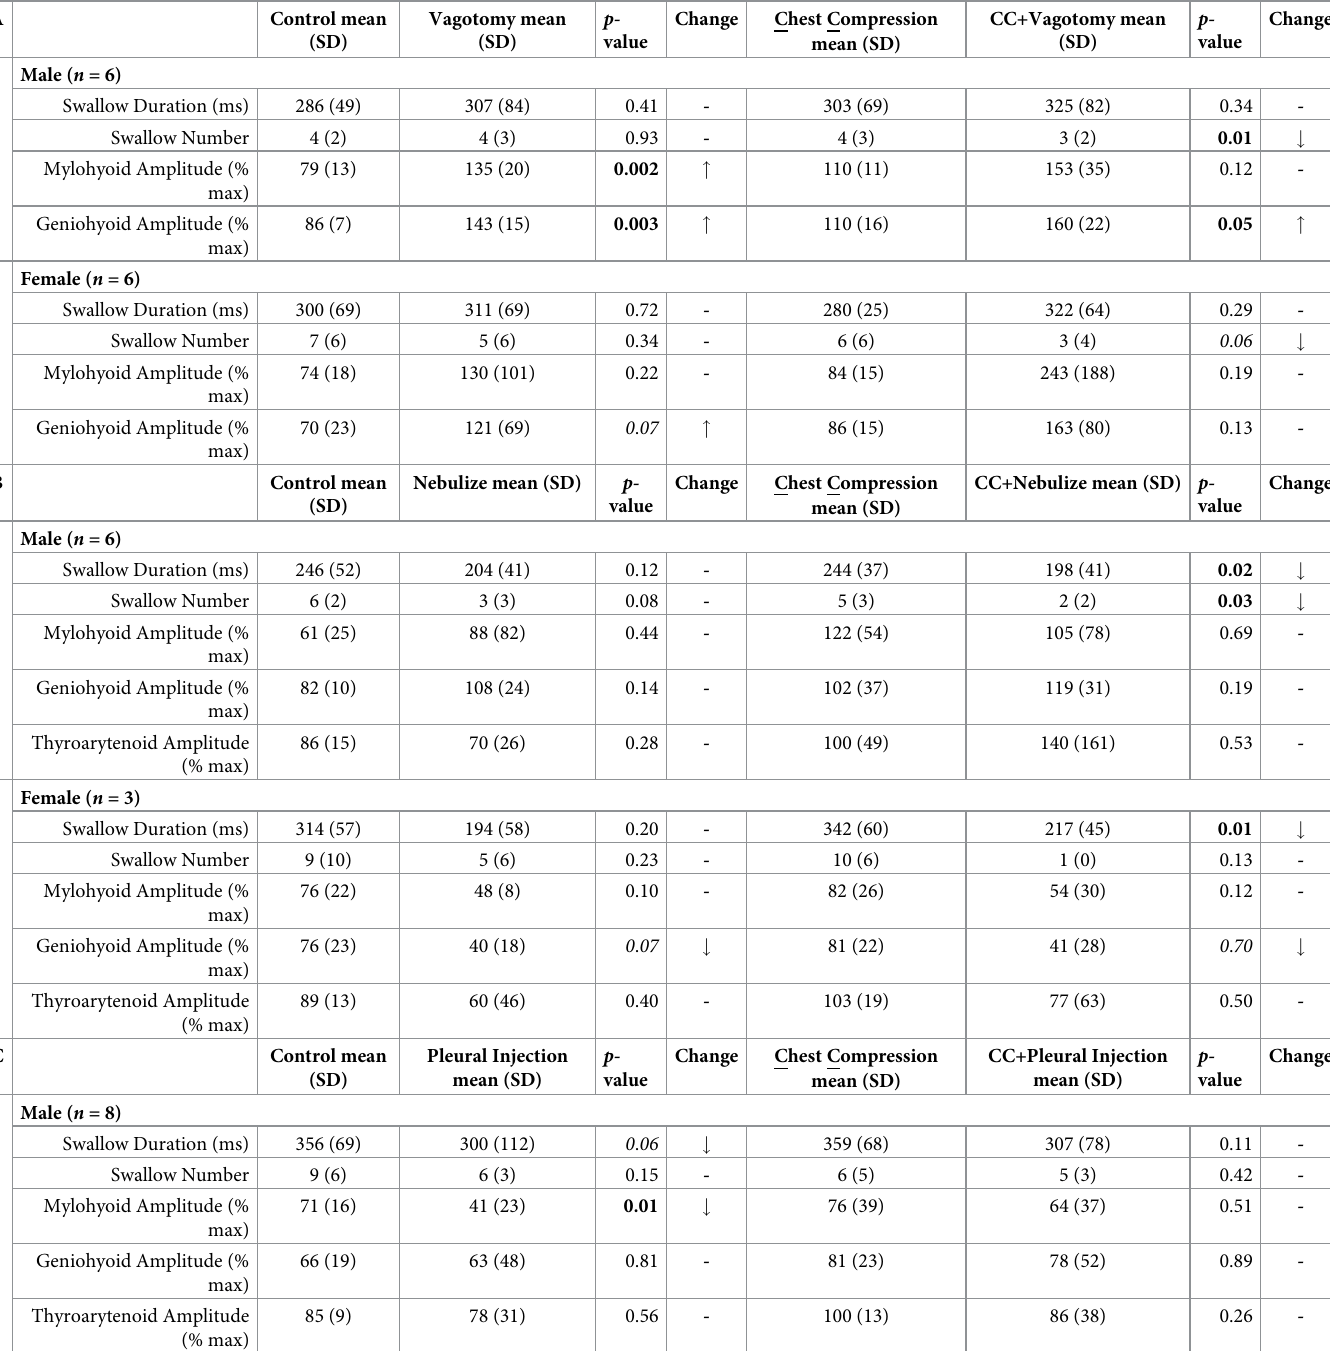
Table 3. Means, Standard Deviation (SD), p -values, and direction of change for swallow parameters during conditions of control (no feedback modulation or chest compression), feedback modulation alone (e.g. vagotomy), chest compression alone (without feedback modulation), and Chest Compression (CC) during feedback modulation conditions for both male and female groups. The left half of the table shows data comparing control conditions (no feedback modulation) to conditions adding vagotomy (A), nebulized lidocaine (B), or pleural injection of lidocaine (C), while the right half compares chest compression with the addition of each intervention. Amplitude is normalized to maximum of control and shown as a